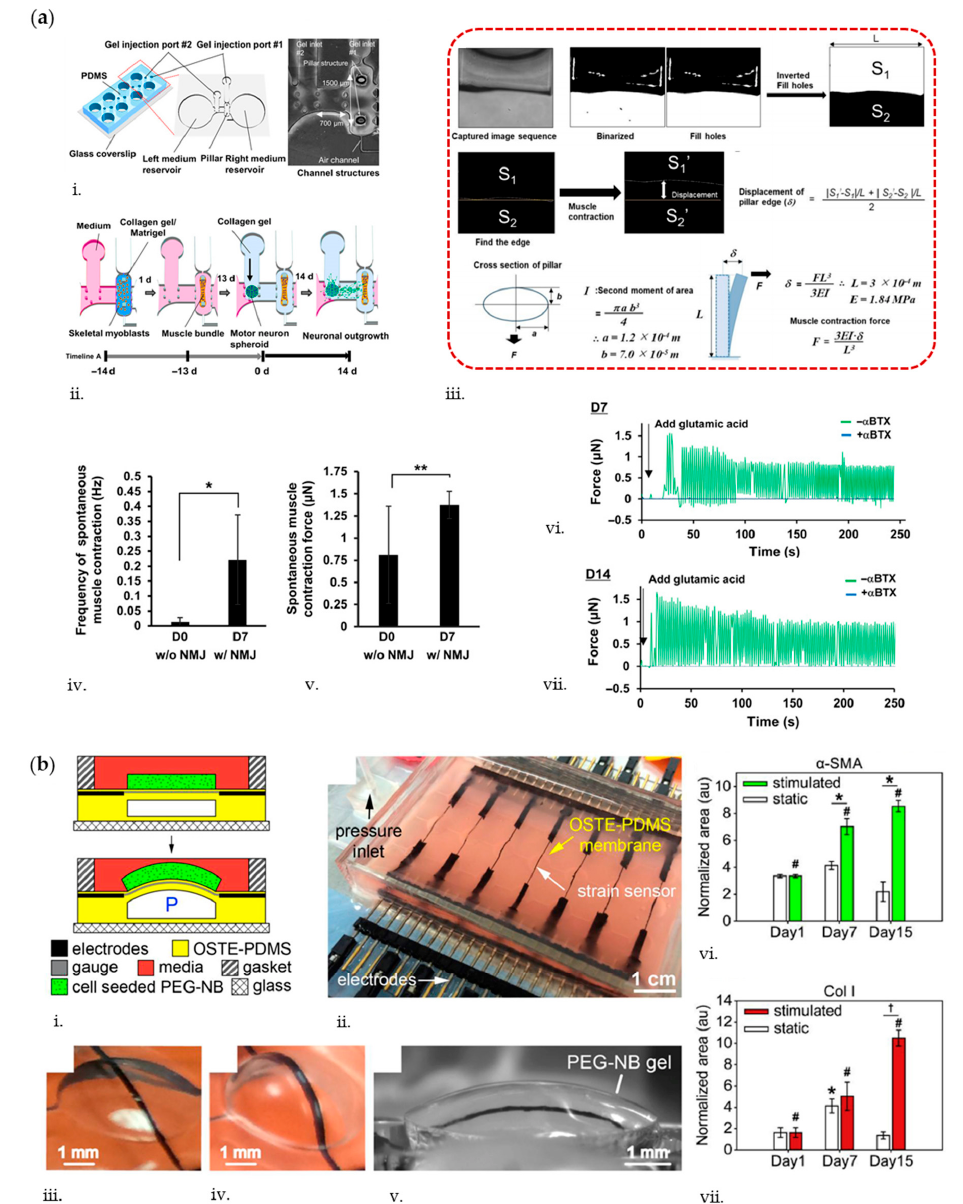
Figure 6. ( a ) Compartmentalized design and picture of a human motor unit on a chip microfluidic device. PDMS microchannels are used to form four identical sites on a single chip, each composed of a muscle fiber bundle attaching pillar structures and culture motor neuron (MN) spheroids. Each site has two medium reservoirs, two gel injection ports, and three compartments (i). Each device has three distinct culture regions: for MN spheroids, muscle tissues, and neurite elongation in the middle. The distance between two pillars is 1500 µm. Schematic of human induced pluripotent stem cells (iPS)-derived skeletal myoblasts seeding (ii): cells injected into the right compartment with the collagen/Matrigel mixture from gel injection port 1. Within 1 day, a skeletal muscle fiber bundle was formed on pillar structures. After 13 days of differentiation, an MN spheroid with collagen gel was injected into the left compartment from gel injection port 2. Neural outgrowth occurs by 14 days,